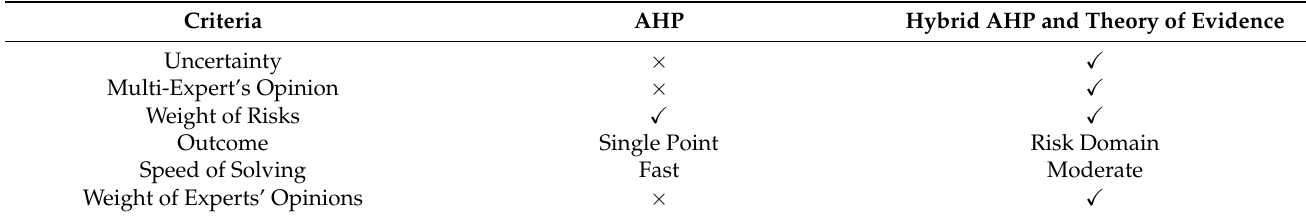
Table 4. Comparing classic AHP to the proposed hybrid AHP and Dempster—Shafer theory of evidence. Criteria AHP Hybrid AHP and Theory of Evidence Uncertainty Multi-Expert’s Opinion